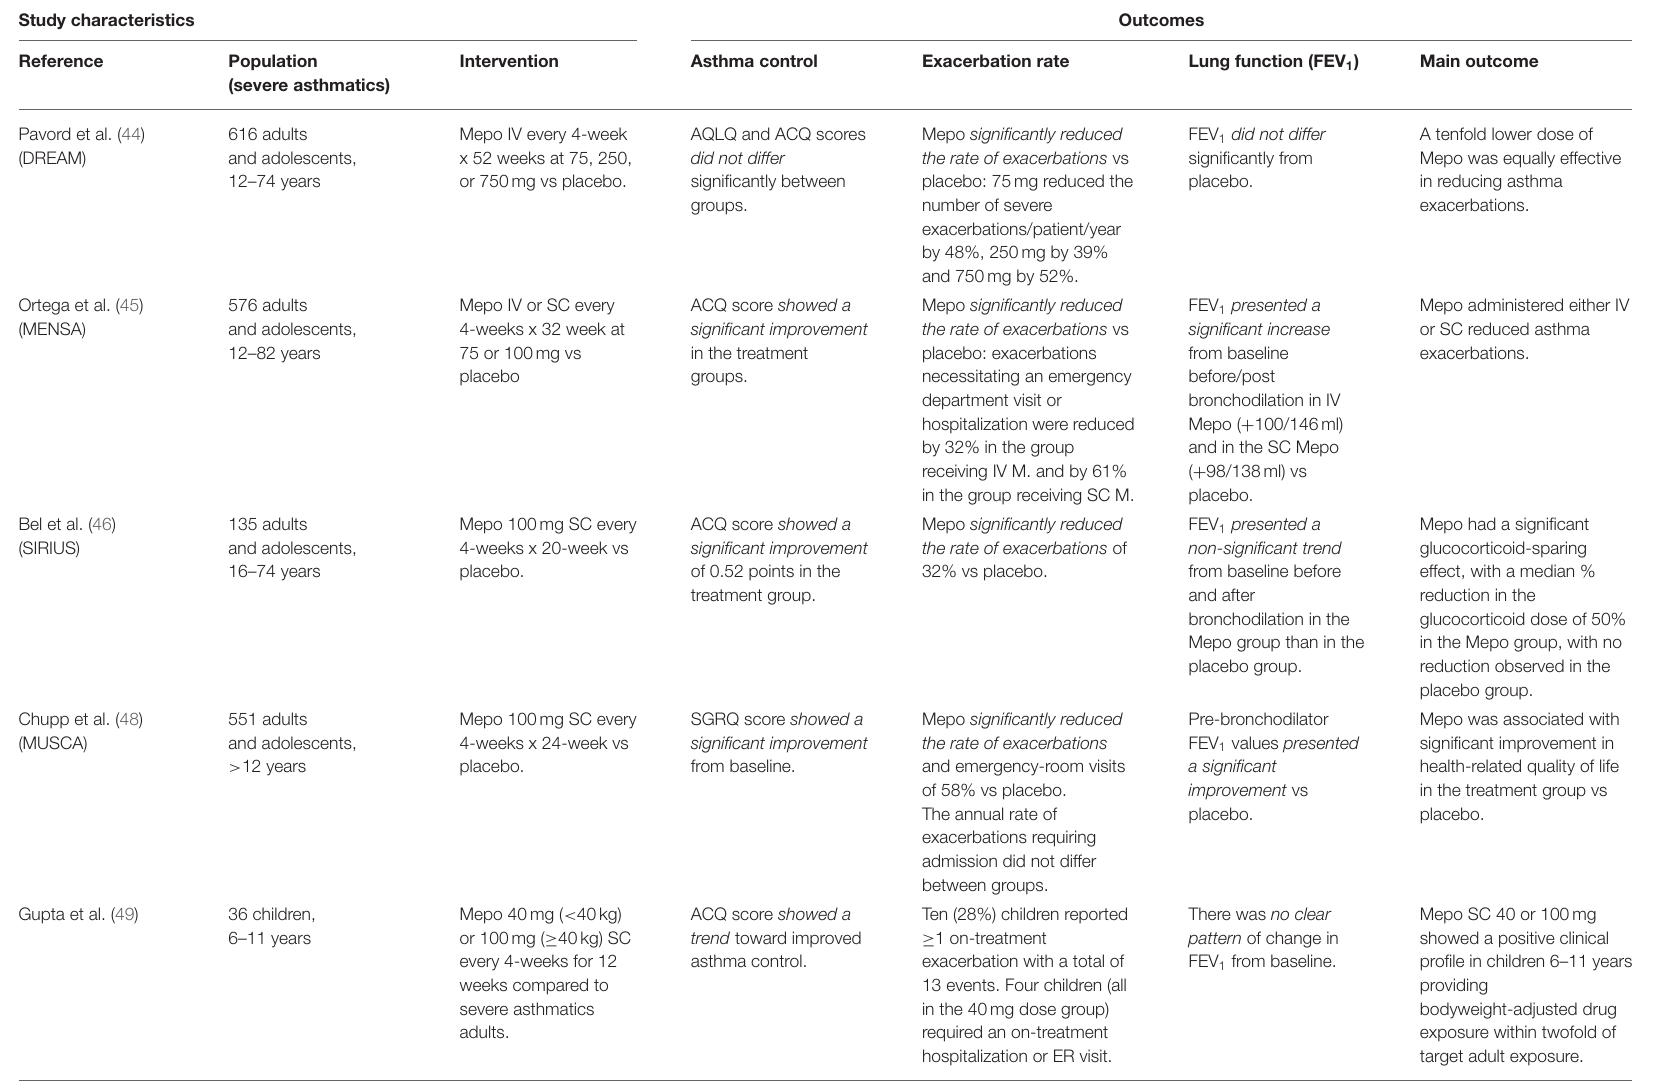
TABLE 2 | Available studies on mepolizumab in adults, adolescents and children with summarized the main outcomes and results. Study